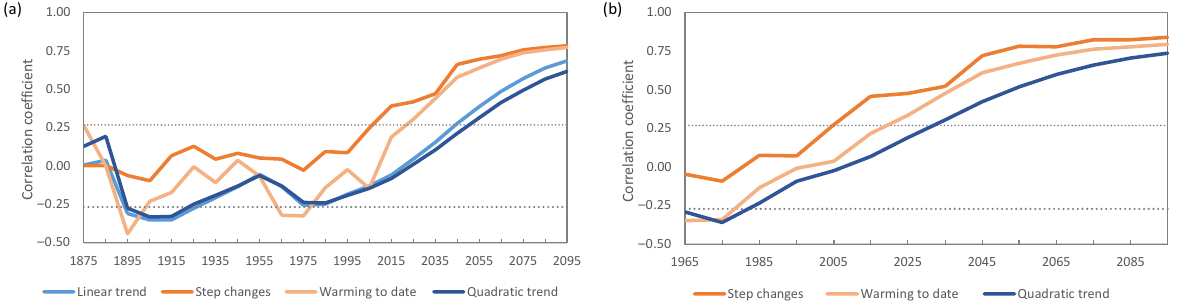
Figure 9. Correlations between ECS and linear trends, total step changes, warming to date and quadratic trends (a) from 1861 to the current decade (warming to date: 1861–99 average subtracted from current decadal average) and (b) from 1961. Dotted lines mark p